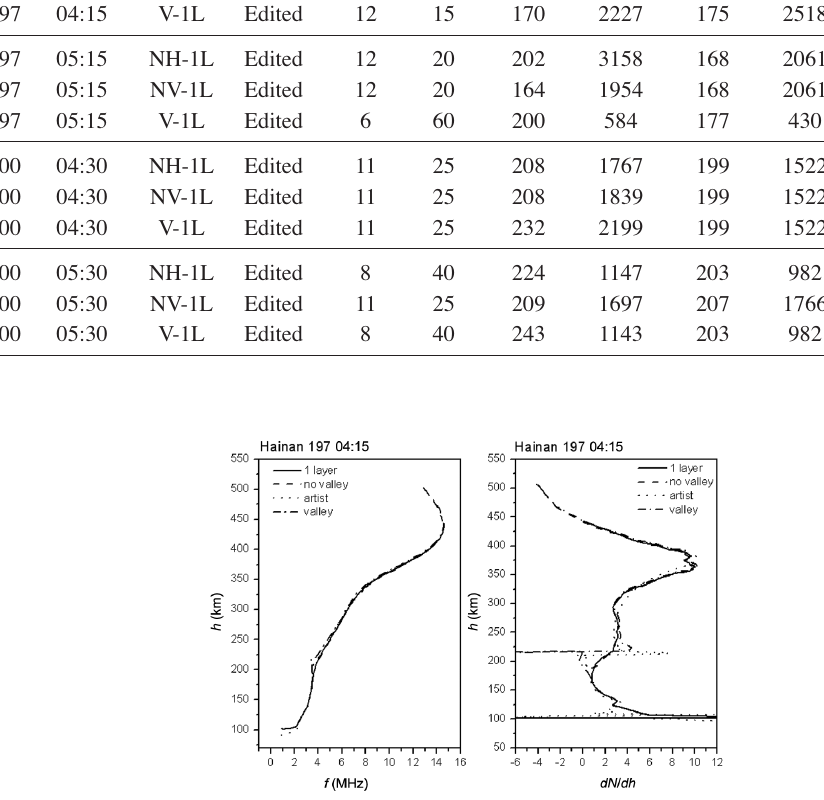
Fig. 1. Electron density profiles and first derivatives dN / dh with different inversion techniques for day 197 and hour 04:15 UT corresponding to Hainan link.